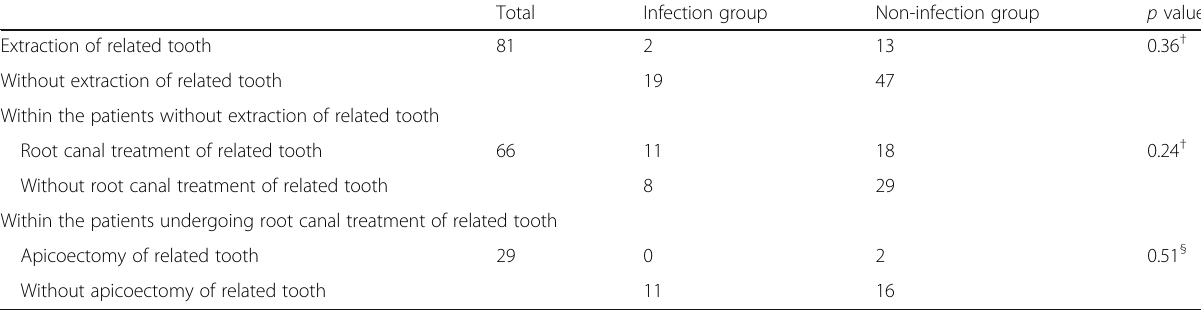
Table 2 Comparisons between groups according to the treatment method of cystic lesion-related mesial